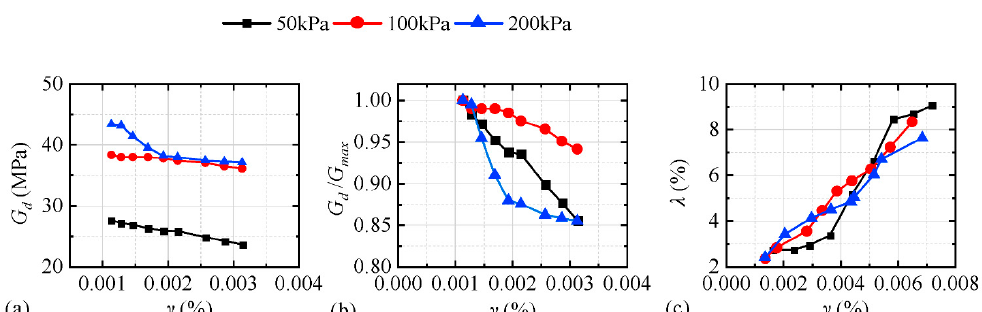
Figure 3. Test results of undisturbed soil: ( a ) Dynamic shear modulus curve of undisturbed soil, ( b ) Dynamic shear modulus curve of undisturbed soil is normalized, ( c ) Undisturbed soil dynamic damping ratio curve.